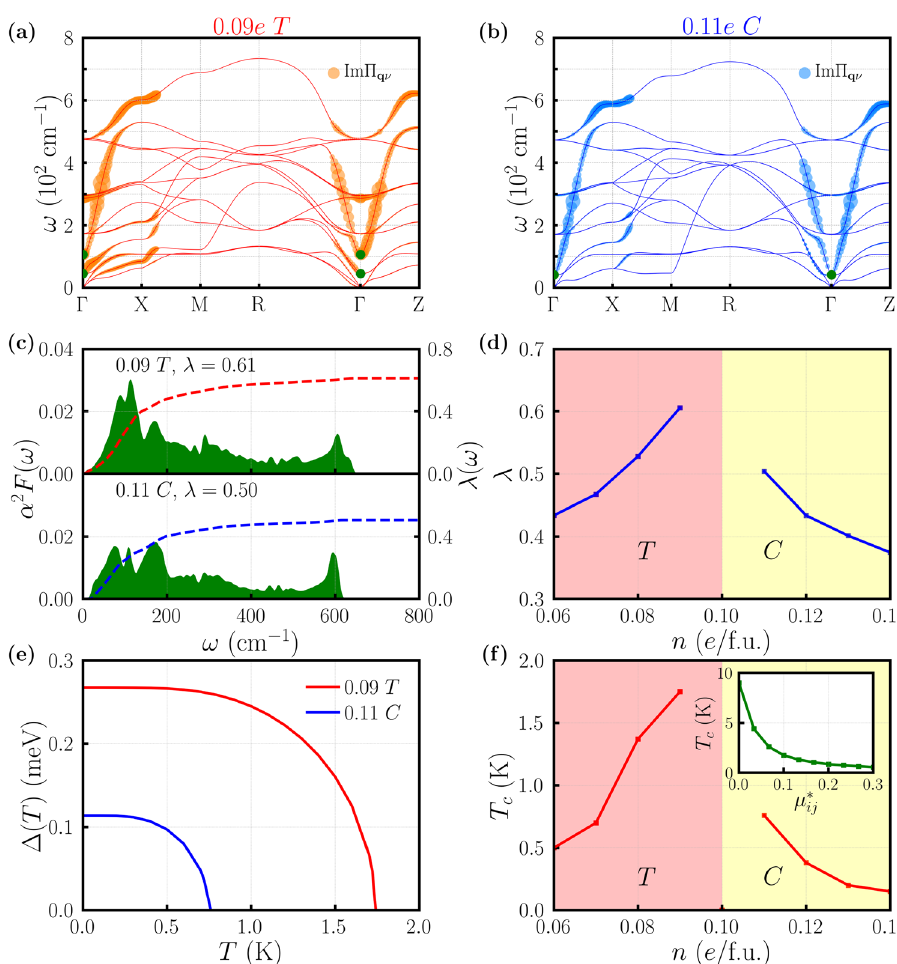
Fig. 3 Electron-phonon properties and phonon-mediated superconductivity in doped BaTiO 3 . a The imaginary part of the electron-phonon self-energy Im Π q ν for each phonon mode of doped BaTiO 3 at 0.09 e /f.u. concentration (tetragonal structure T ). The point size is proportional to Im Π q ν . The largest = 4.6 meV. The green dots highlight the zone-center polar optical phonons. b The imaginary part of the electron-phonon self- point corresponds to Im Π q ν energy Im Π q ν for each phonon mode of doped BaTiO 3 at 0.11 e /f.u. concentration (cubic structure C ). The point size is proportional to Im Π q ν . The largest point corresponds to Im Π q ν = 3.2 meV. The green dots highlight the zone-center polar optical phonons. c Electron-phonon spectral function α 2 F ( ω ) and accumulative electron-phonon coupling λ ( ω ) of doped BaTiO 3 at 0.09 e /f.u. and 0.11 e /f.u. concentration. The total electron-phonon coupling λ is 0.61 for the former and 0.50 for the latter. d Total electron-phonon coupling λ of doped BaTiO 3 as a function of electron concentration n . e Superconducting gap Δ of doped BaTiO 3 as a function of temperature T at 0.09 e /f.u. concentration (red) and at 0.11 e /f.u. concentration (blue), calculated by the three-orbital ¼ 0 : 1 is used for each orbital pair. f Superconducting transition temperature T Eliashberg equation. The Morel-Anderson pseudopotential μ (cid:2) c of doped ij BaTiO 3 calculated by the Eliashberg equation as a function of electron concentration n . The inset shows T c of BaTiO 3 in the tetragonal structure at 0.09 e /f. u. concentration as a function of Morel-Anderson pseudopotential μ (cid:2) ij